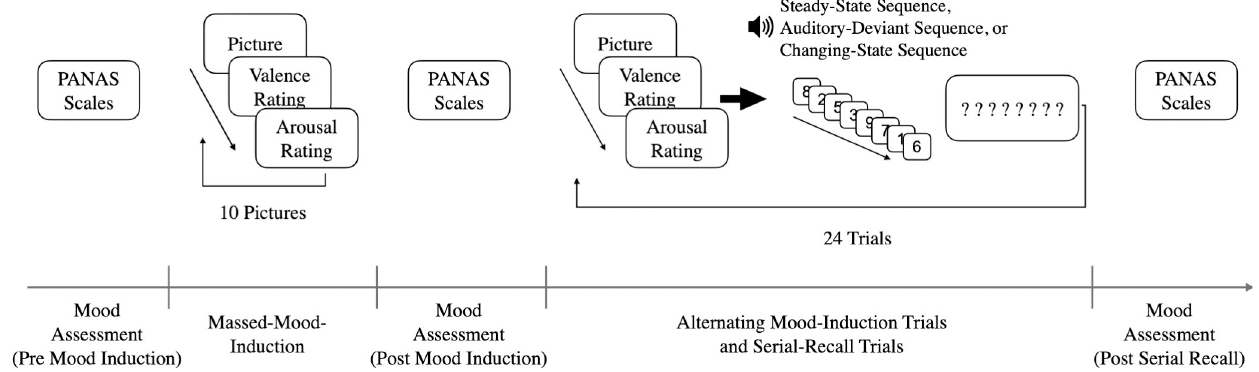
Fig 4. Schematic illustration of the experimental procedure of Experiment 3 following the serial-recall training trials.